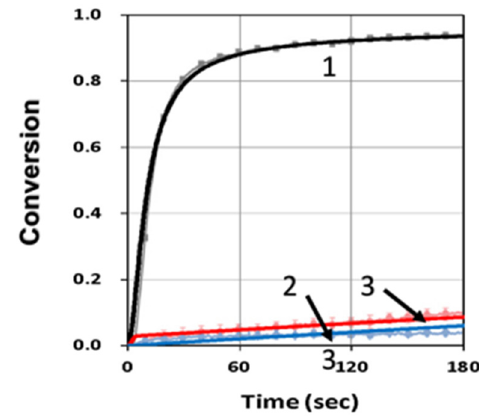
Figure 4. Conversion profiles for blue-only (black curve—1), UV-only (blue curve—2) and both-light (red curve—3), for C 10 = 0.2%, C 30 = 3.0%, b 1 = 0.1, b 2 = 0.007, k” = 35; where solid color curves are calculated and bars are measured data of de Beer et al. [10].